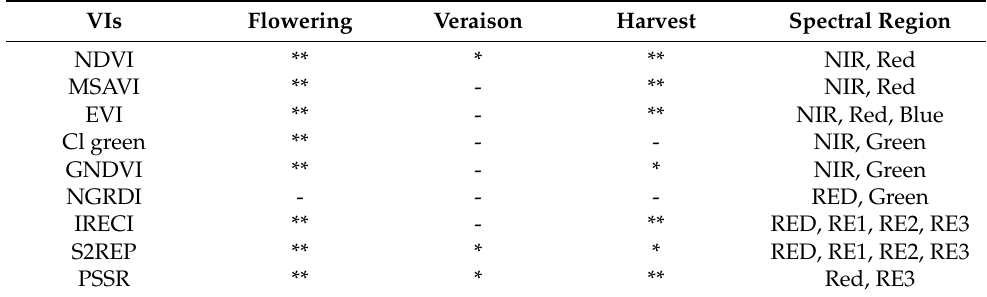
Figure 9. Spatial distribution of three groups on the PDO zone. One-way ANOVA analysis between the VIs parcels of each group for every DOY have been conducted and evaluated as for their statistical significance. Table 6 presents VIs that show statistically significant differences between the three groups on at least one DOY of each phenology stage. Table 6. One-way ANOVA statistically significant differences between the Vis values in the three